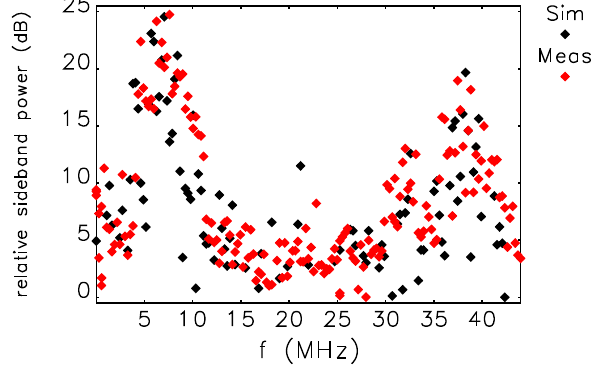
FIG. 9. Measured and simulated vertical beam spectrum for normal 324 bunch operation. The points shown are the lower vertical betatron